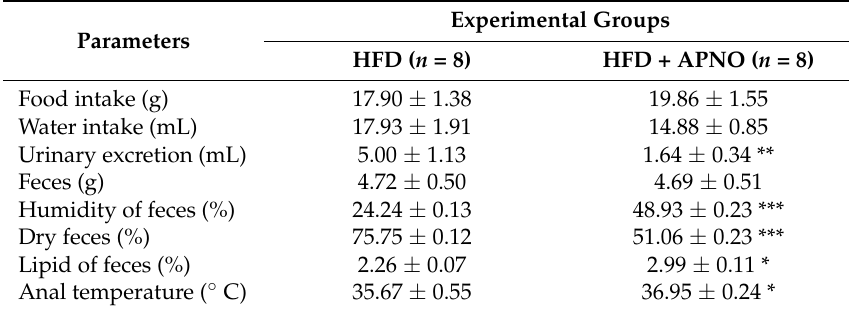
Table 3. The metabolic parameters of high-fructose diet-induced hyperlipidemic rats treated with